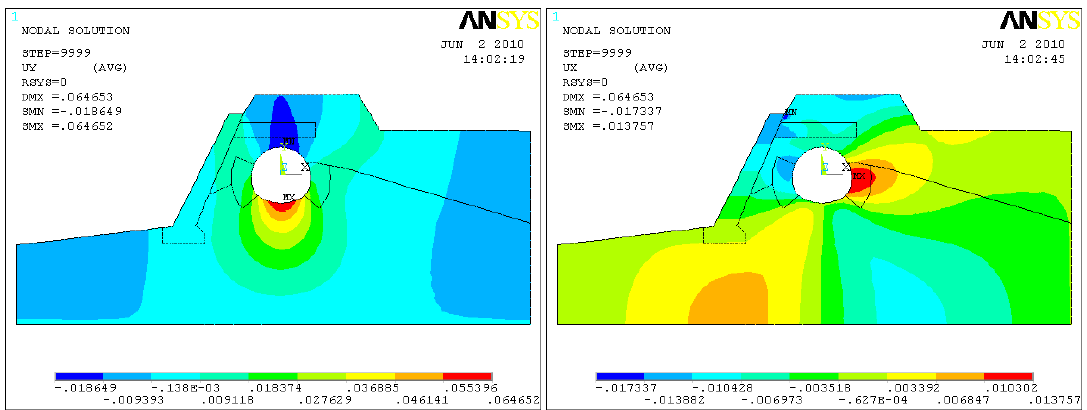
Fig. 7 Vertical displacement and horizontal displacement caused by tunnel